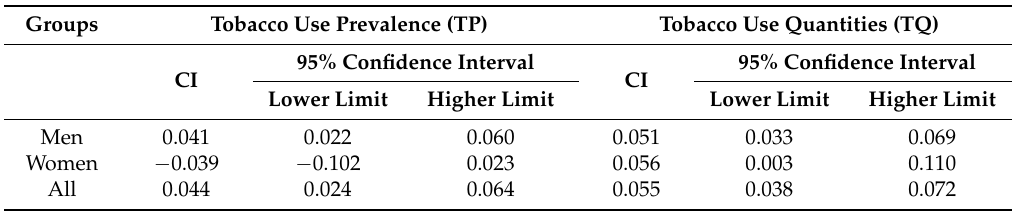
Table 3. Concentration index of smoking incidence and tobacco use quantities for the older adults in